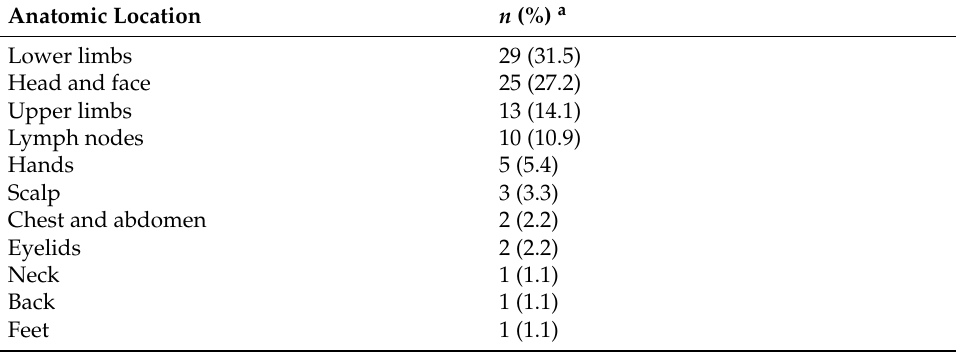
Table 2. Anatomic location of MCC at